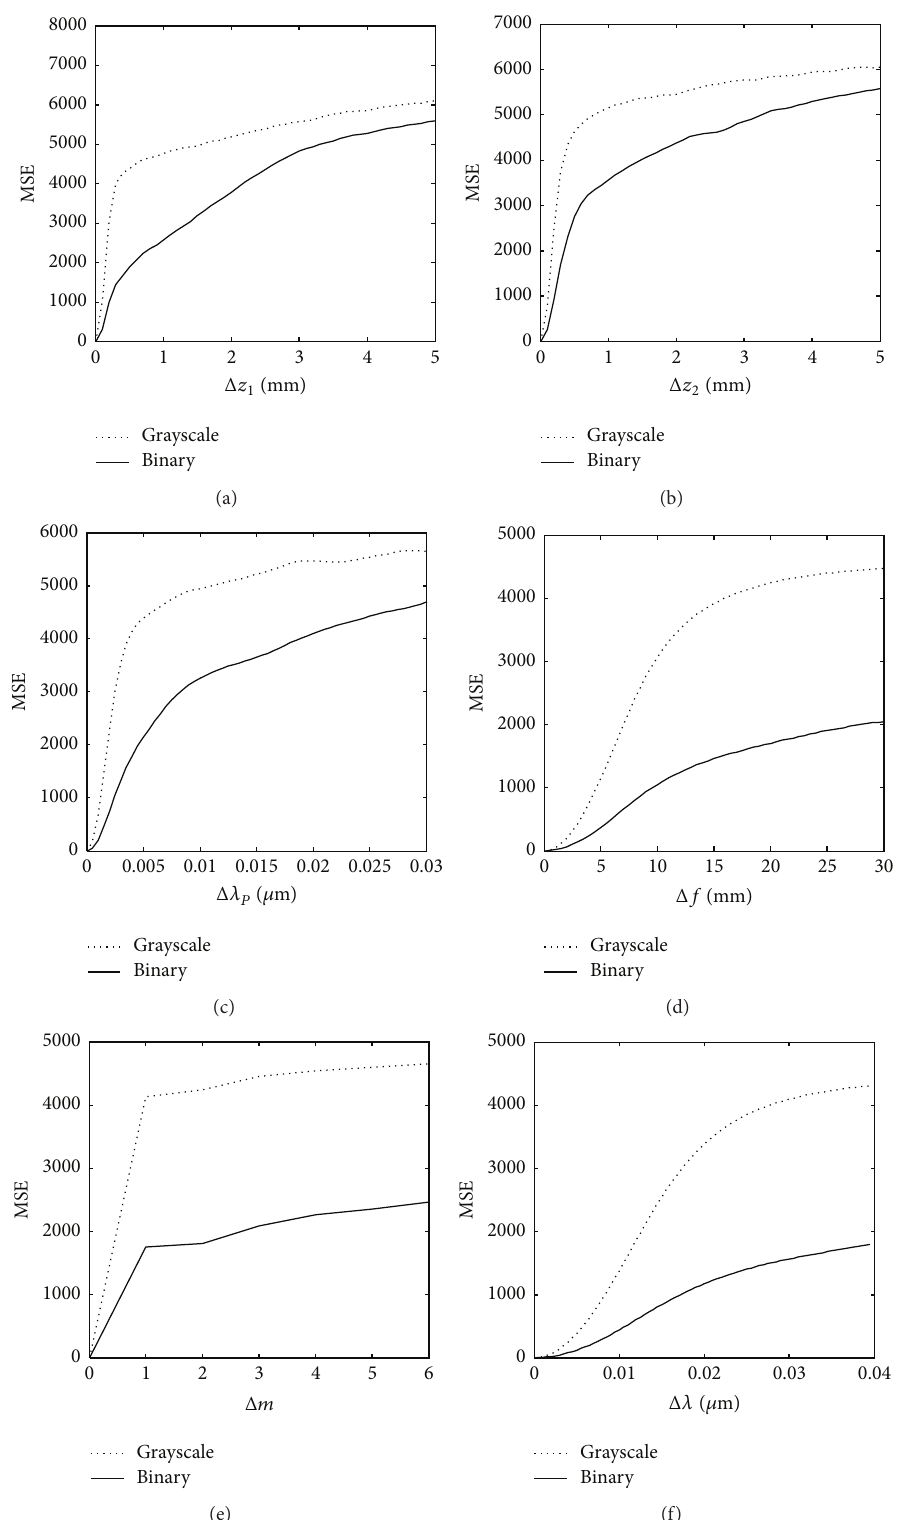
Figure 8: Sensitivity plots of MSE as a function of deviation from the correct values of various parameters of FrT and DVTL: (a) Δ𝑧 1 (mm), (b) Δ𝑧 2 (mm), (c) Δ𝜆 𝑝 ( 𝜇 m), (d) focal length 𝑓 (mm), (e) topological charge 𝑚 , and (f) wavelength 𝜆 ( 𝜇